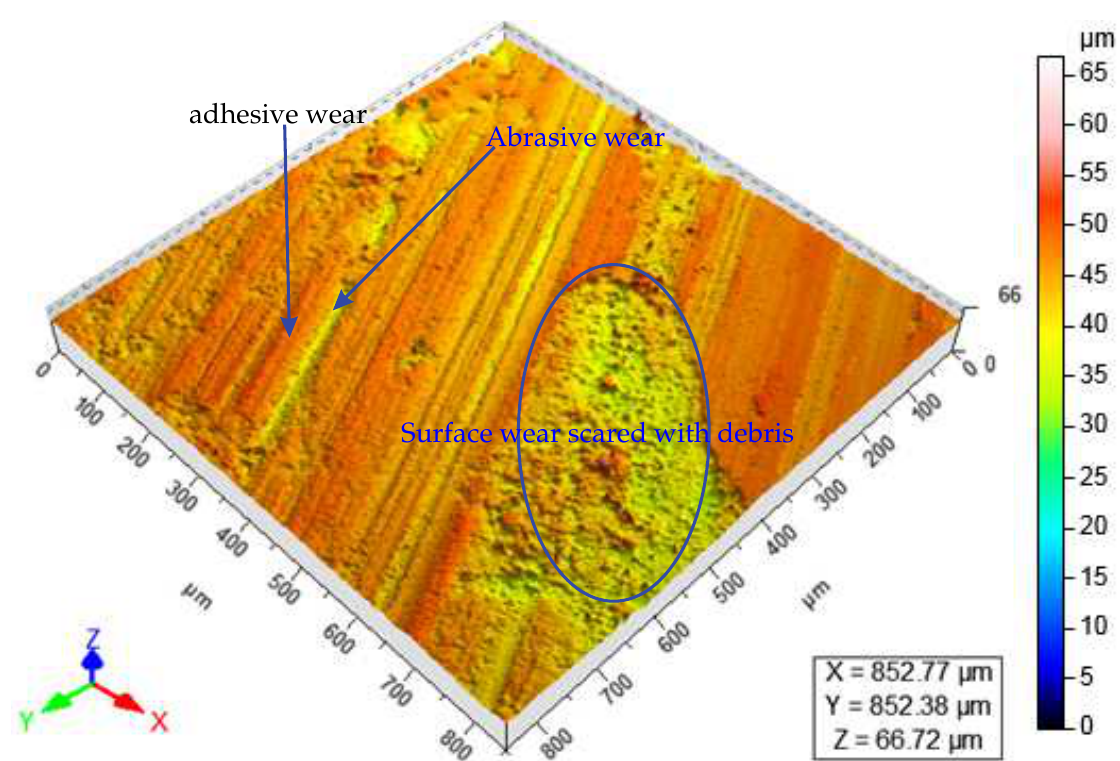
Figure 8. Surface topology (x50) and wearing worn distribution of alloyed Al-CuMgMn with laser 1.9 kW